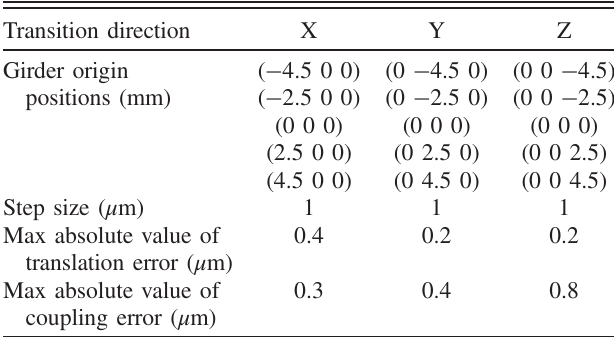
TABLE VII. Resolution in three transition directions.